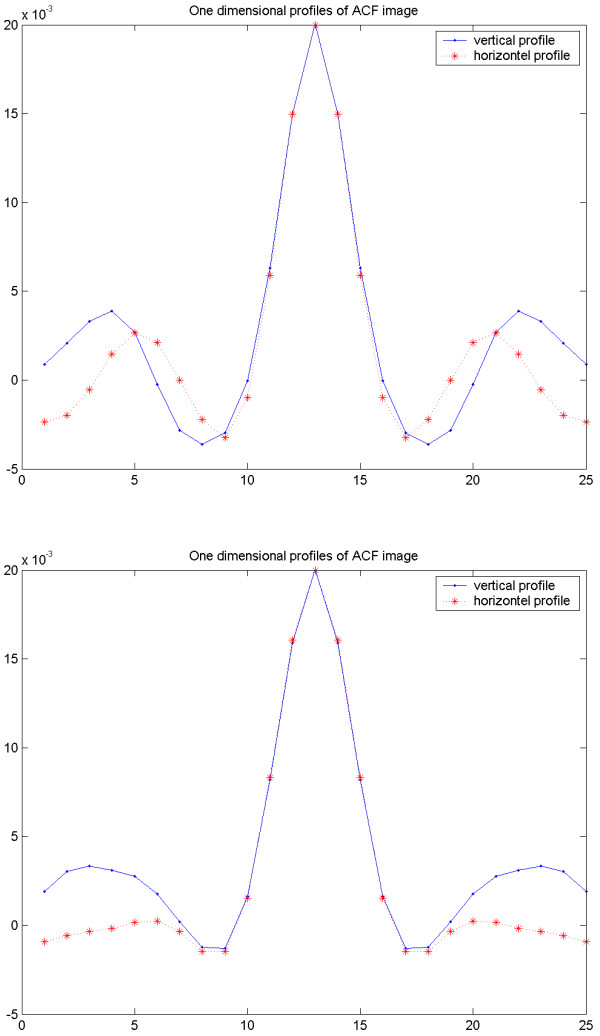
Results of the cylindrical NEMA phantom study. Vertical (dash point) and horizontal profile (dash star) through the centre of the ACF image from 2D (upper) and from 3D acquisition image (lower) reconstructed using FBP with 6 mm Gaussian filter.